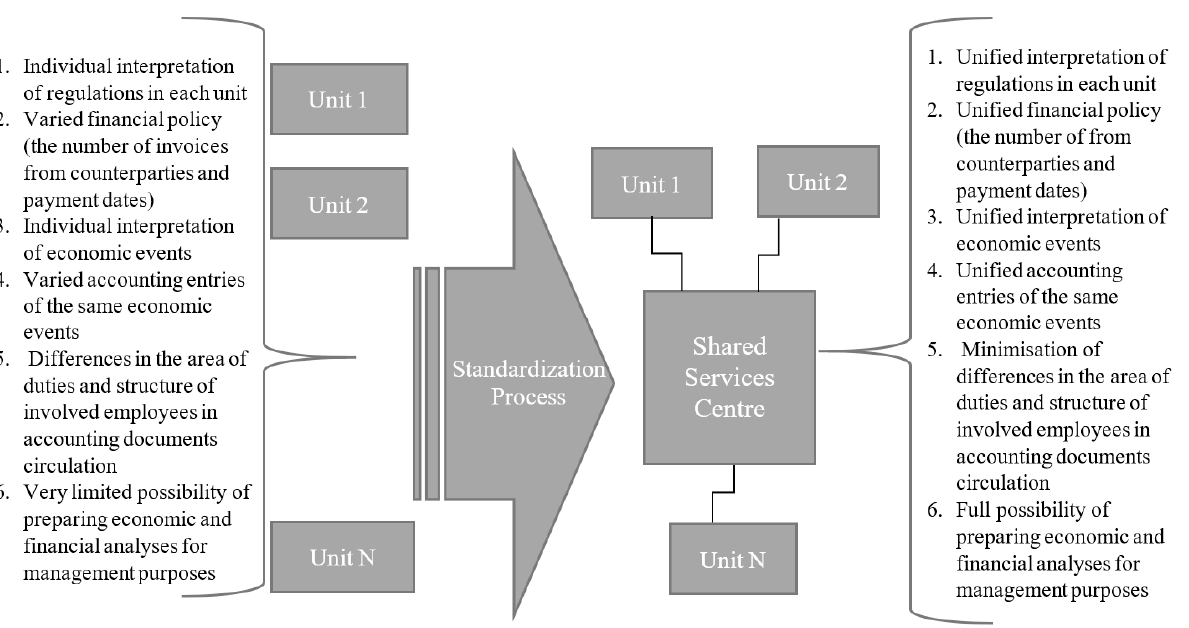
Figure 5. The scope and effects of accounting processes standardization in local government shared services centers (the example of an SSC in the city of Toru ń , Poland). Source: Modrzy ń ski, P., Karaszewski, R., Reuben, A. (2018), p. 69 [53].